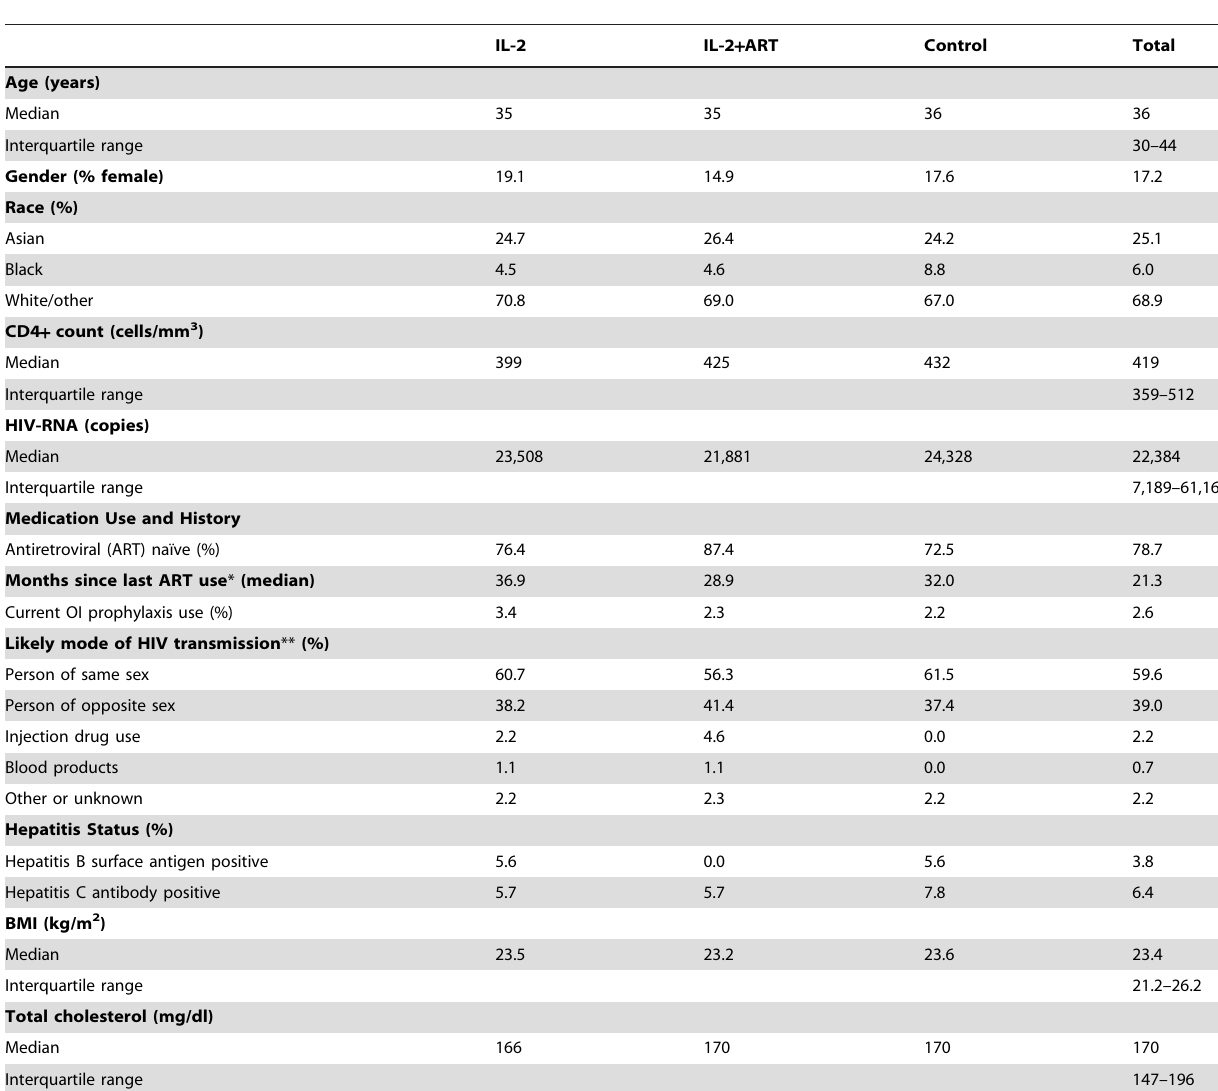
Table 1. Baseline characteristics by treatment